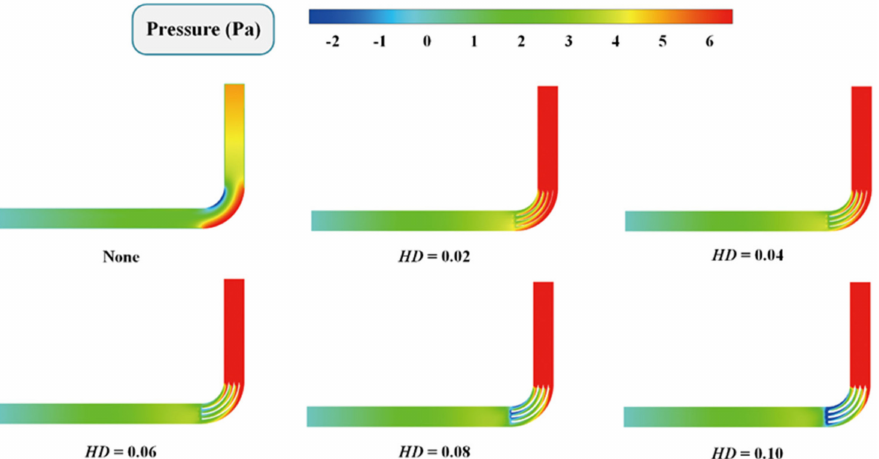
Figure 12. Pressure contour in 90 ◦ bend pipe with different thick − diameter ratio deflectors.